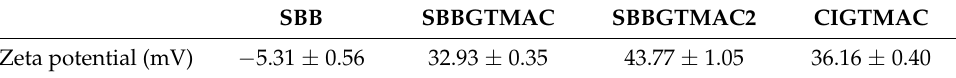
Table 2. Zeta potential values measured for crude polysaccharide and corresponding cationic derivatives. The results are presented as mean of three independent measurements ± standard deviation (SD). SBB SBBGTMAC SBBGTMAC2 CIGTMAC Zeta potential (mV) − 5.31 ± 0.56